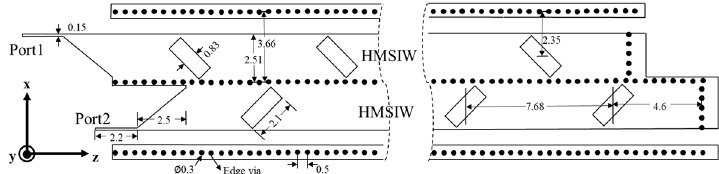
Figure 3. Equivalent circuit of the slot.